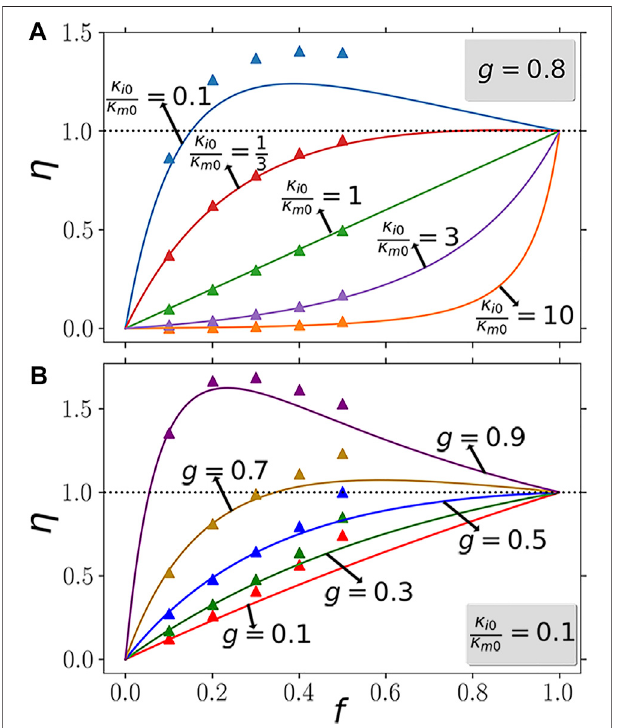
FIGURE 5 | Same as Figure 4 , but for linear inclusions and nonlinear matrix. In addition, to show directional nonlinearity enhancement, κ i 0 / κ m 0 takes 3 in (B)